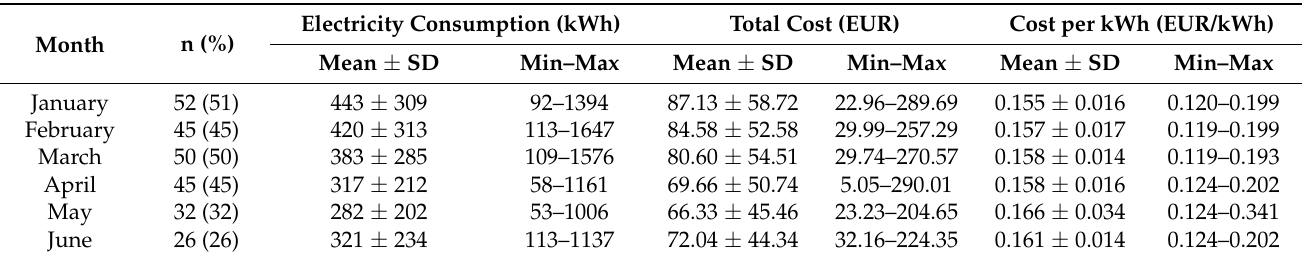
Table 2. Summary of the results collected through the participants’ electricity invoices.